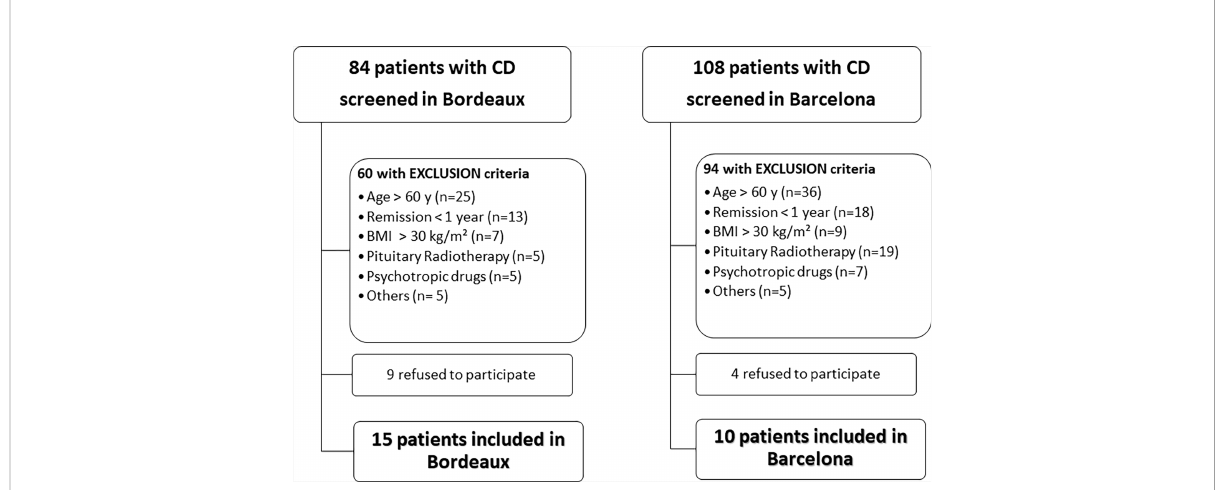
FIGURE 1 Flow chart of the recruitment of patients with Cushing ’ s disease (CD) in the two investigating centers.